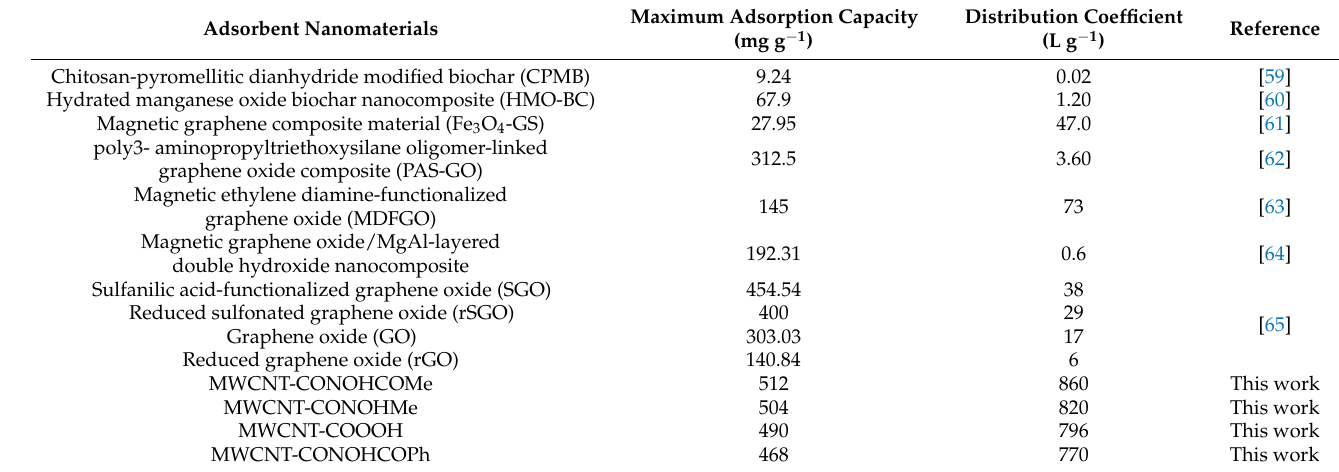
Table 3. A review of the performance of some carbon-based adsorbent materials used to remove Pb(II) from water.